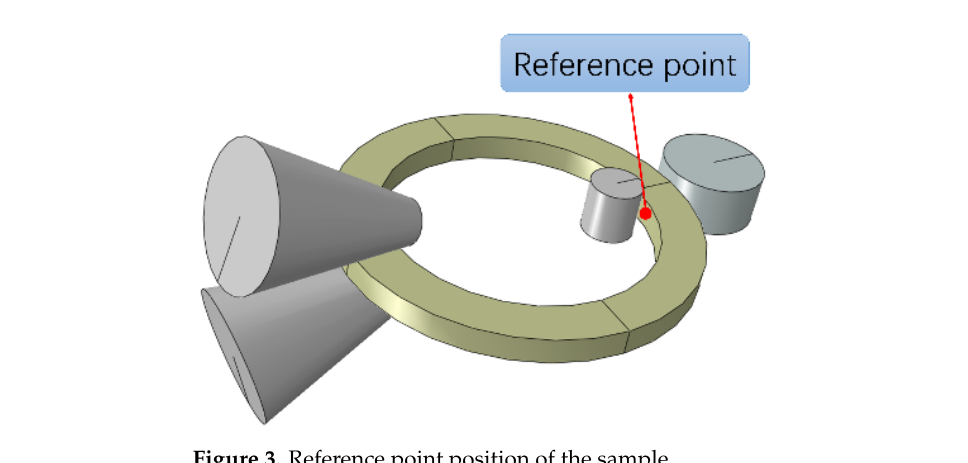
Figure 3. Reference point position of the sample.